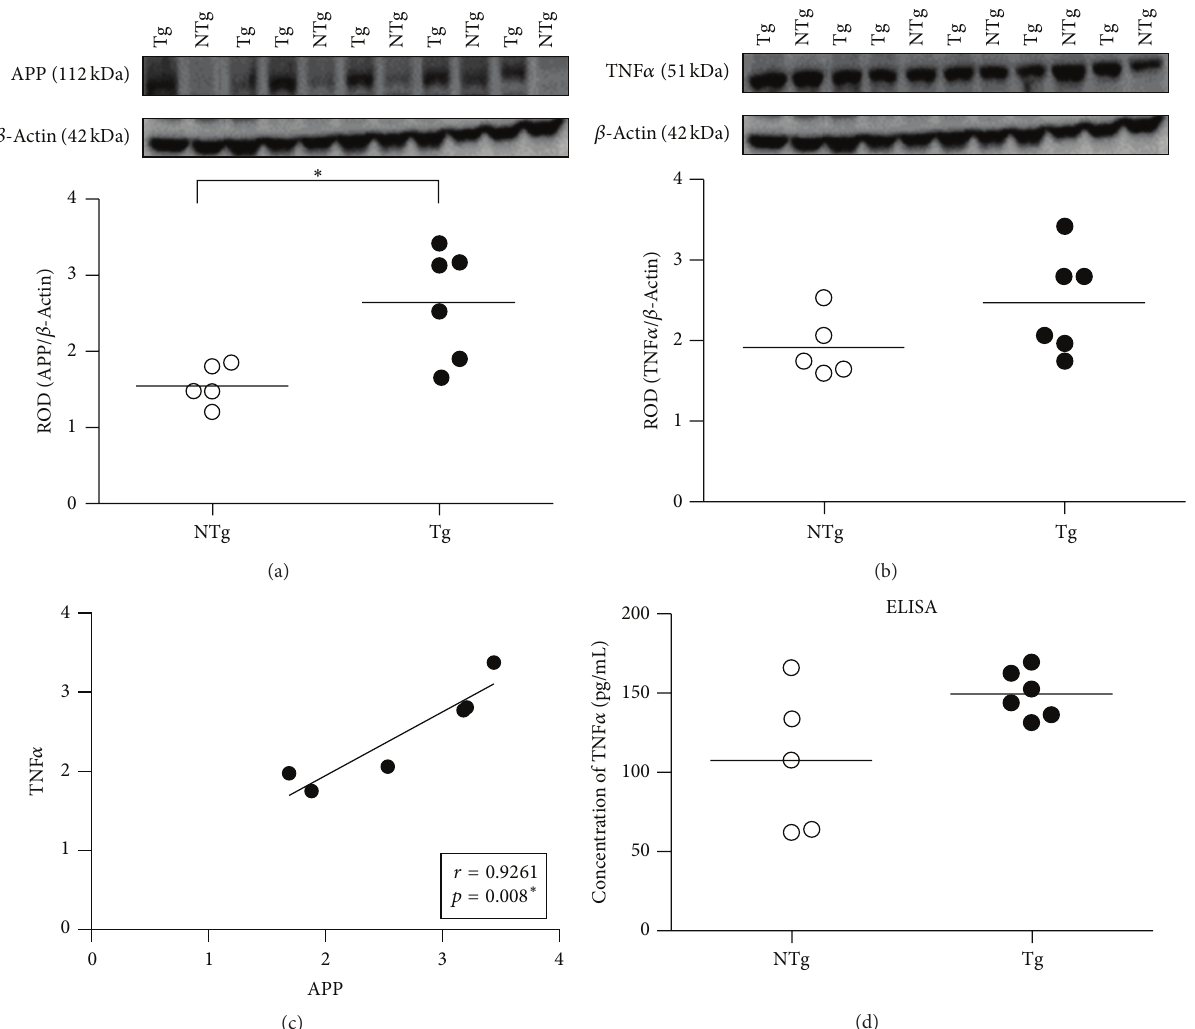
Figure 1: APP and TNF 𝛼 expression in the hippocampus of 3-month-old APPswe/PS1dE9 mice. (a) APP (112kDa) and (b) TNF 𝛼 (51 kDa) expressions were determined by Western blotting. Equal protein loading was ascertained by the parallel assessment of 𝛽 -actin (42kDa) and results were expressed as the relative optical density (ROD). (c) In APPswe/PS1dE9 mouse group, the increase in APP correlates positively with TNF 𝛼 ( 𝑟 = 0.9261 ; 𝑝 = 0.0080 ). Correlation analysis between respective ROD values as determined in Western blot studies (a and b) was performed by linear regression. (d) The level of TNF 𝛼 was also assayed by ELISA and expressed in pg/mL protein. Each depicted point corresponds to the individual quantitative measures obtained for each WT ( 𝑛 = 5 ) and APPswe/PS1dE9 ( 𝑛 = 6 ) per genotype group; ∗ indicates 𝑝 < 0.05 . NTg: wild type; Tg: APPswe/PS1dE9.